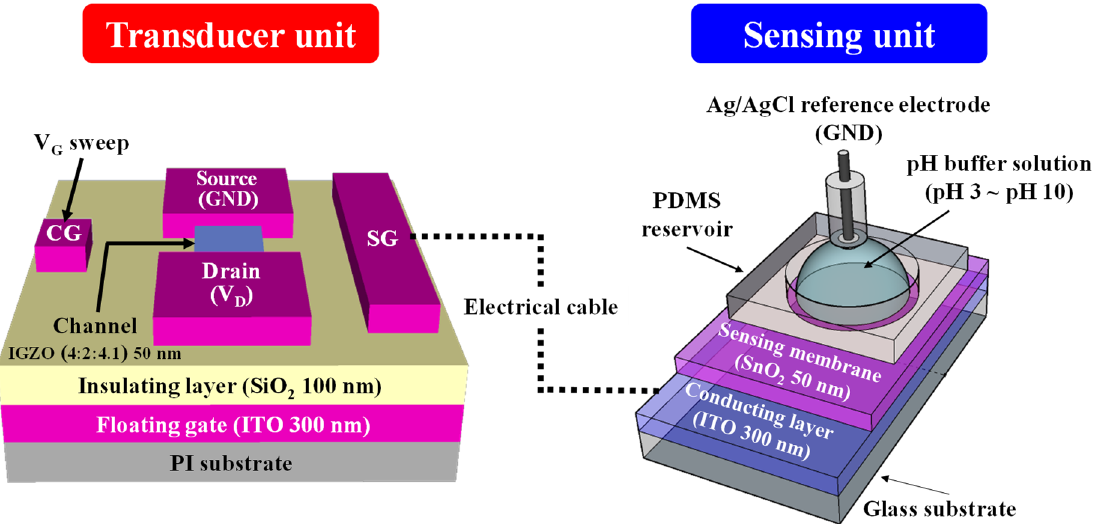
Figure 1. Schematic illustration of an a-IGZO coplanar dual-gate TFT transducer and SnO 2 EG sensing units. The dotted line represents the electrical connection between the two units. Reference electrode is connected to the ground unit of measurement instrument.